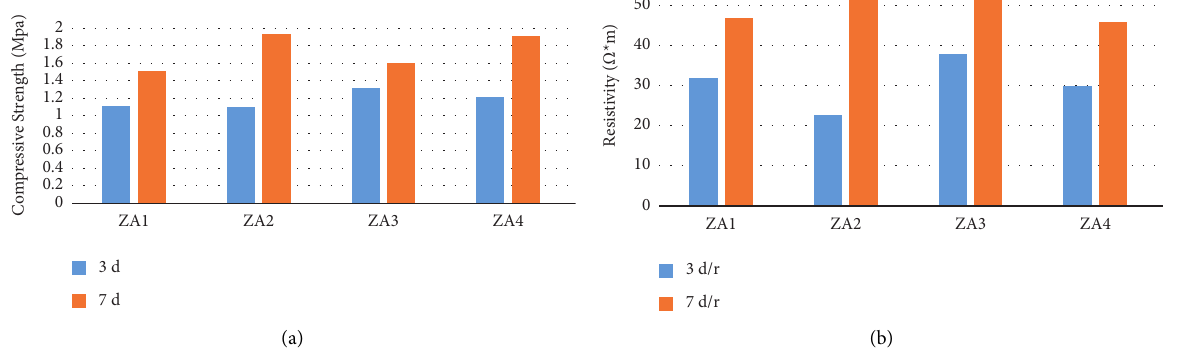
Figure 16: Comparison of strength level results.